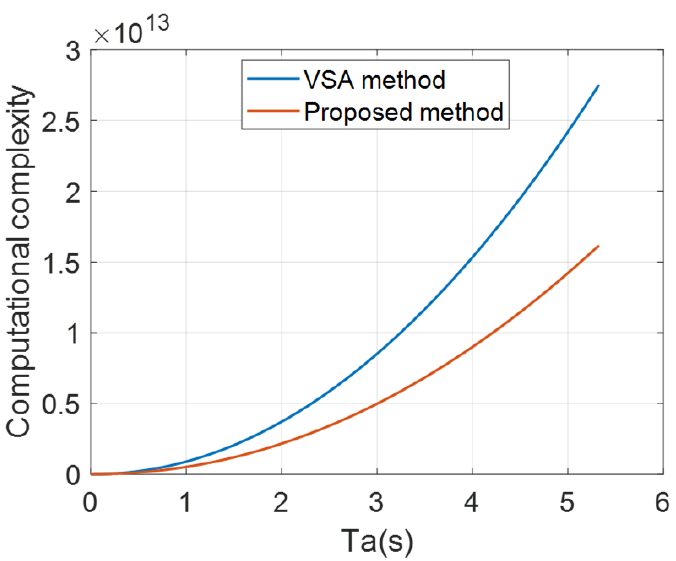
Figure 9. Results of computational complexity